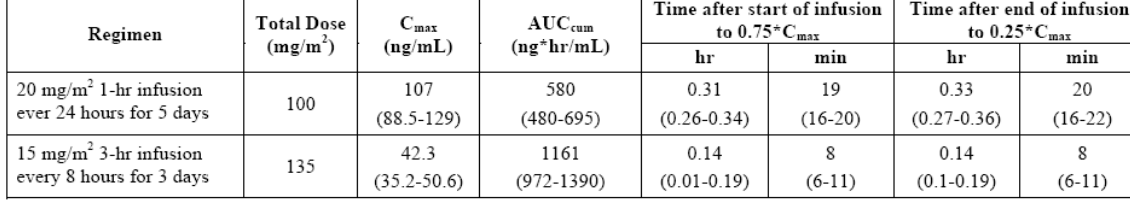
PK parameters were independent of time with no dependency on study cycle and no accumulation observed within the